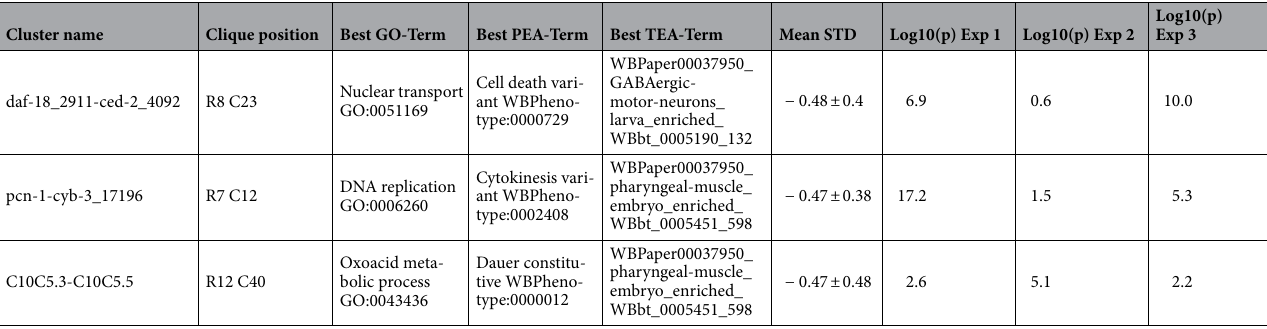
Table 2. Most strongly affected cliques by hsp-90 RNAi and their characteristics. Clique positions (letter = row, number = position from left to right) correspond to the clique map shown in Fig.